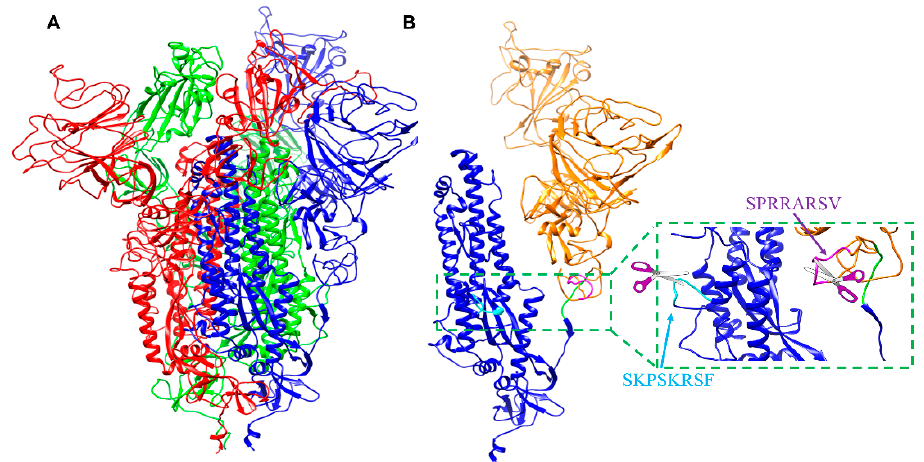
Figure 1. Model of the SARS-CoV2 spike glycoprotein and processing sites. ( A ) Molecular model of the trimeric (red, blue, and green) S-glycoprotein from SARS-CoV2. The model was obtained by Swiss3D model repository and based on the experimentally derived structure of the protein (PDB ID 6VSB) [1]. ( B ) Molecular model of the S-glycoprotein as in ( A ) but only one chain is displayed. The S1 N-terminal subunit is shown in orange, while the S2 C-terminal subunit is depicted in blue. The S1 furin cleavage site, the S2 cleavage site, and second S2 ′ cleavage site, are highlighted in magenta, green, and cyan respectively.